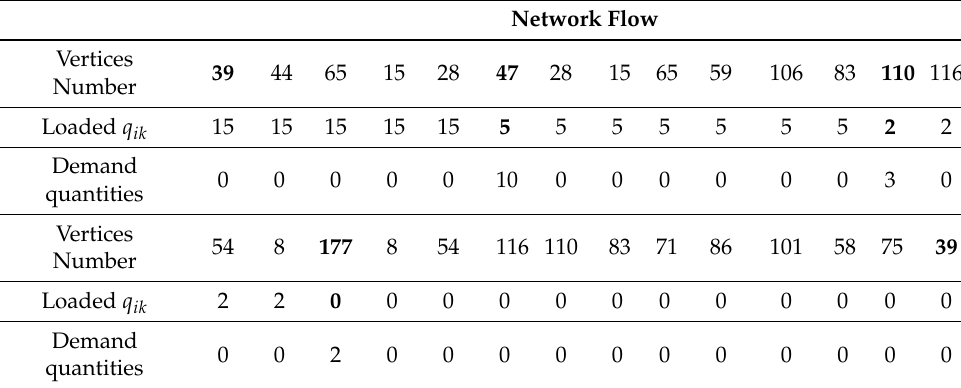
Table 2. Paths and delivered quantities of the UAV.